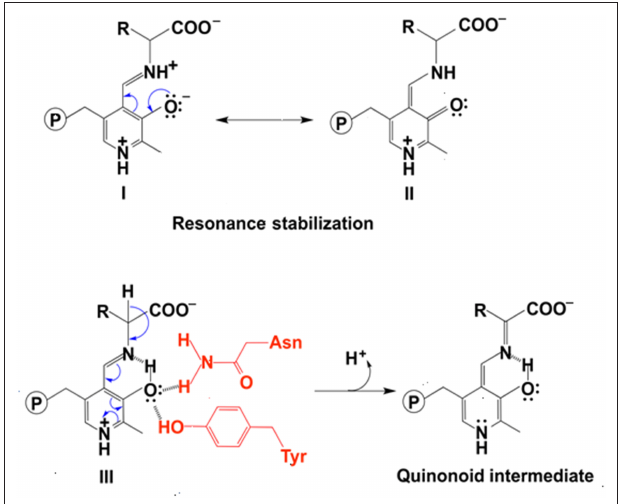
FIGURE 3 | The effect of protonation states of O3 ′ on delocalization. The stabilization of ionized O3 ′ (form I) through resonance structure (form II). The electron withdrawing effect of PLP with a neutral O3 ′ (form III) and formation of quinonoid intermediate (Toney, 2014) are